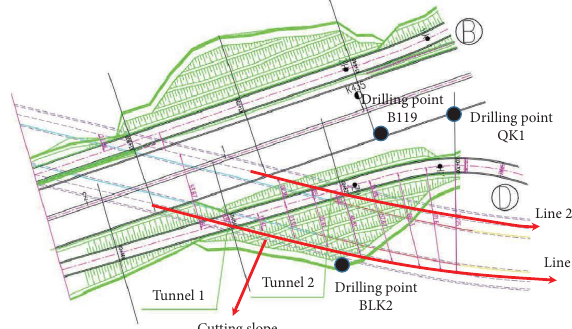
Figure 6: Survey line layout.